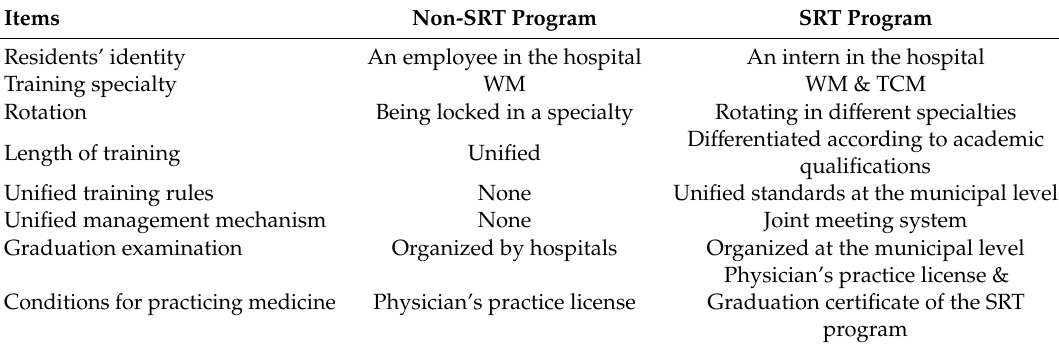
Table 1. Di ff erence between SRT program and non-SRT